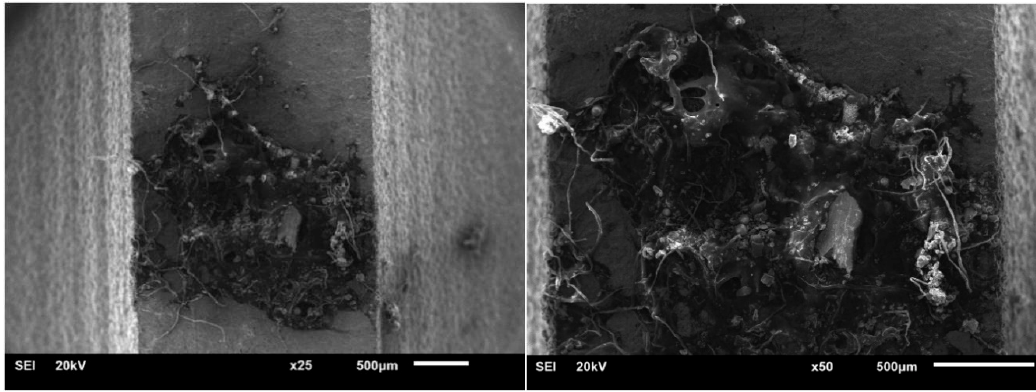
Figure 11. SEM diagrams of the dark gray zone of the U_6 specimen under 2five-fold and 50-fold magnification.